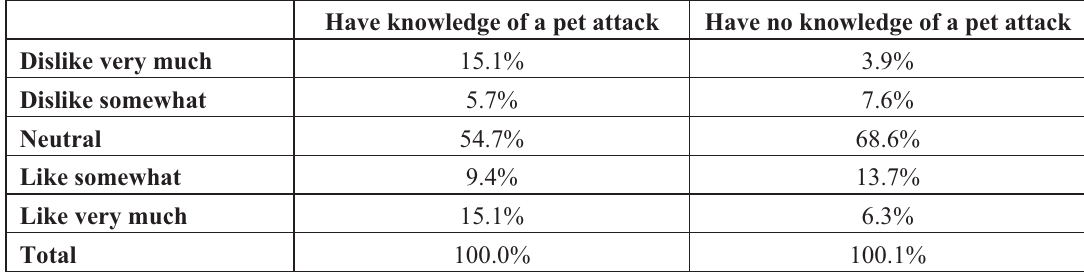
Table 12. The relationship between knowledge of a pet attack by a coyote and how much the respondents liked or disliked coyotes. Results of a chi-square test for independence.